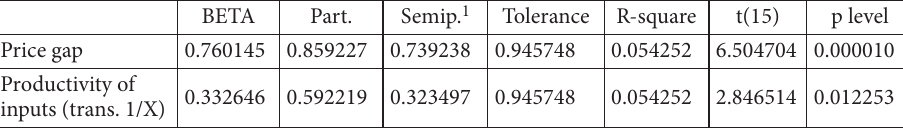
Table 4. Partial and semi-partial correlations for variables from Eq. (2) BETA Part.